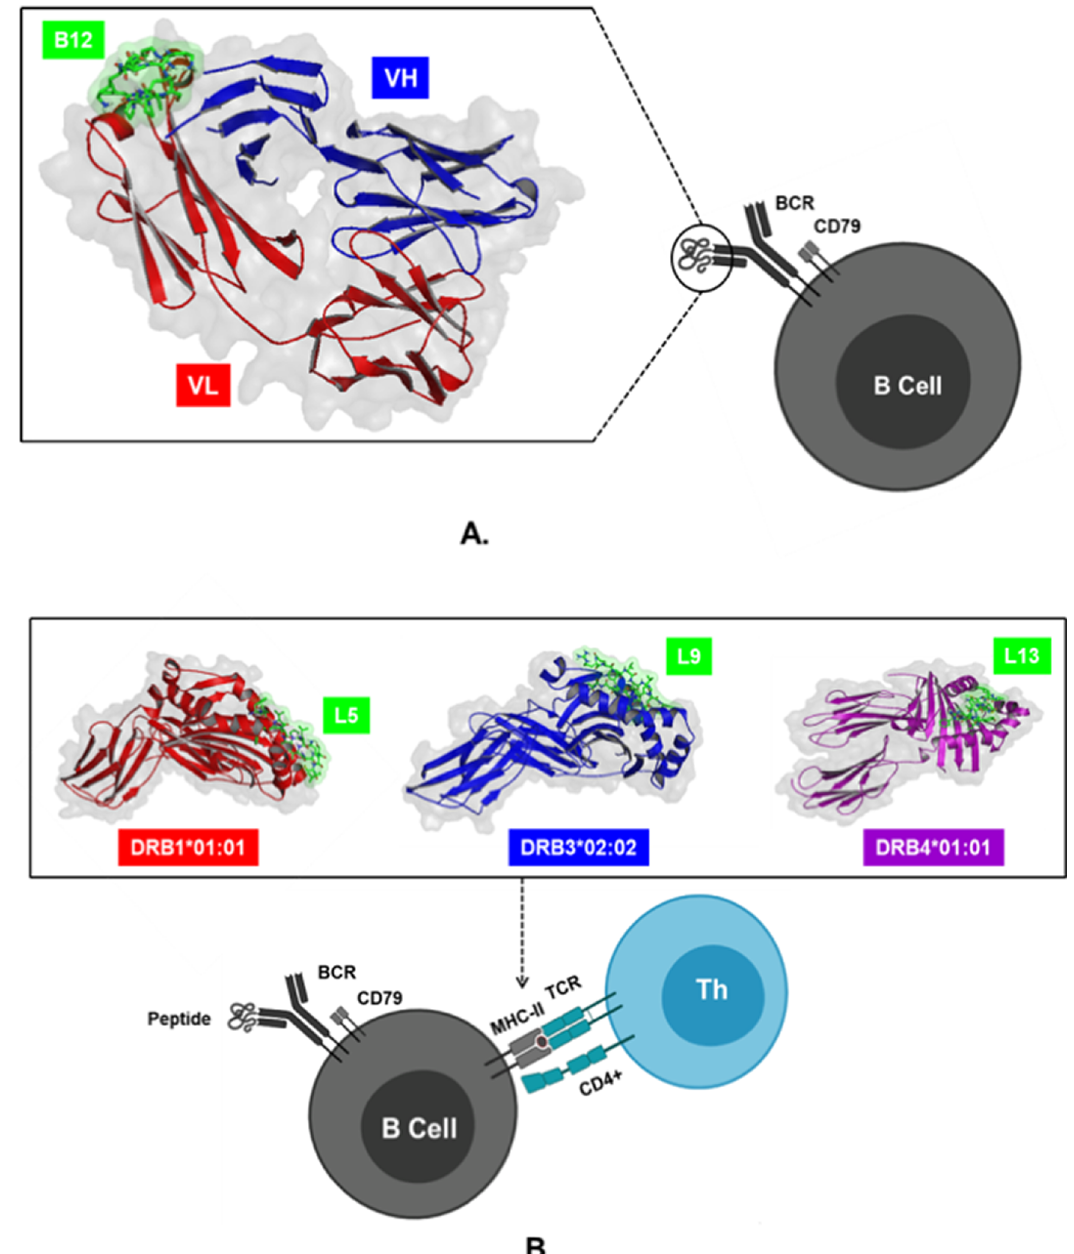
Figure 3. Visualization of peptide-protein docking results. (A) Interaction of B12 peptides with variable light (VL) and heavy (VH) chains on the B cellreceptor (BCR) through direct B cellactivation pathways. (B) Interaction of L5, L9, and L13 peptides bound to region A on MHC-II encoded by HLA-II to trigger activation B cells through an indirect mechanism with the help of CD4+ T The direct B cell activation pathway is triggered by peptide binding to the Fab region on the BCR, which allows signal transduction through CD79, and then triggers transcription factors involved in the activation, maturation, and prolifer- ation of plasma cells, resulting in the production of IgM antibodies. 19,46 On the other hand, the indirect pathway of activation occurs due to the representation of MHC-II by B cells, and its recognition by TCR on CD4+ T cells. 20,47 Peptides with high binding affinity to MHC-II and encoded by specific HLA alleles are predicted to act as T cell epitopes. 11 The binding of the vaccine candidate peptide to the B cell receptor is identified by the lowest energy produced by the molecular docking complex. The lowest energy with a more negative value, is estimated to indicate the